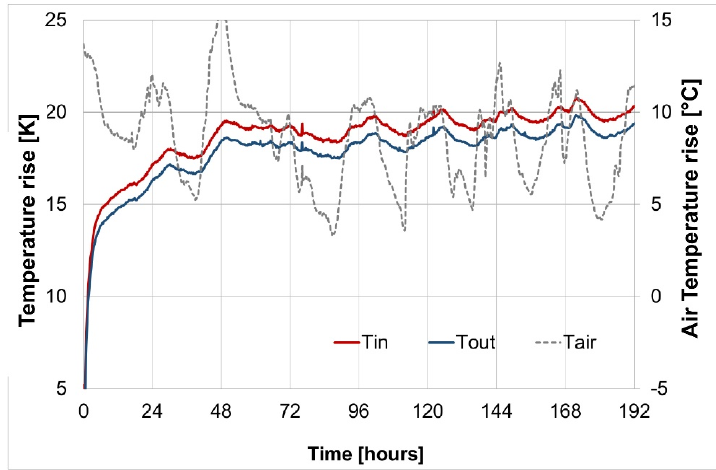
Figure 11. Example of a thermal response test affected by ambient conditions.